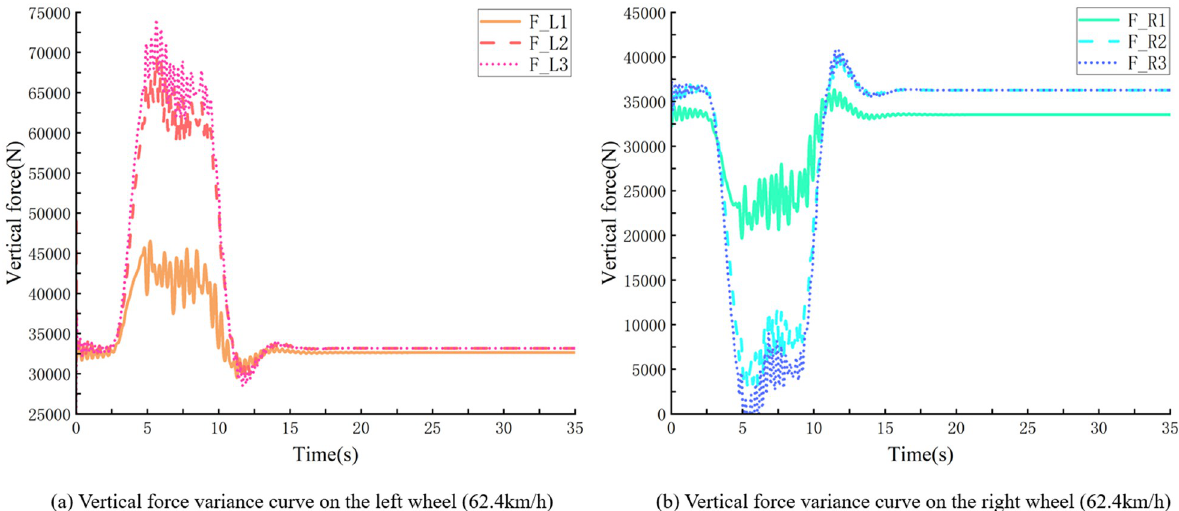
Fig 9. Vertical force curve of vehicle’s left and right wheels bending (62.4 km / h ).